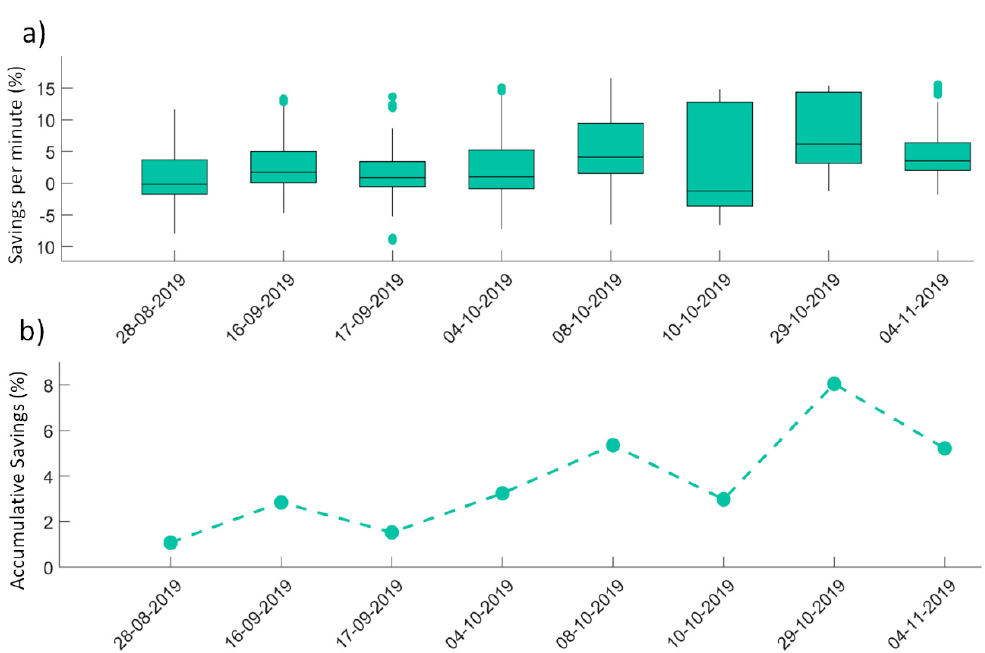
Figure 10. Savings achieved by the proposed methodology during the eight testing days. ( a ) Boxplot of the instantaneous saving per minute of each testing day. ( b ) Accumulative saving of the proposed method during the evaluation period of each day.